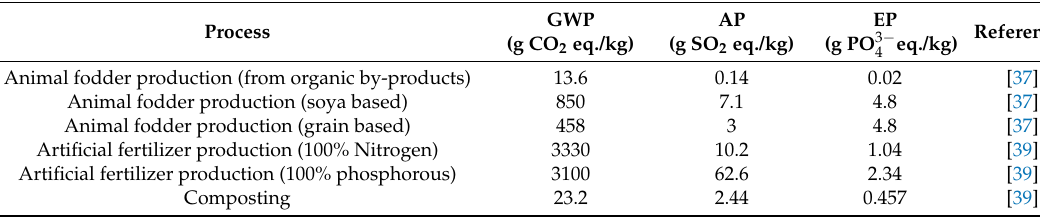
Table A6. Other specific emissions used in the